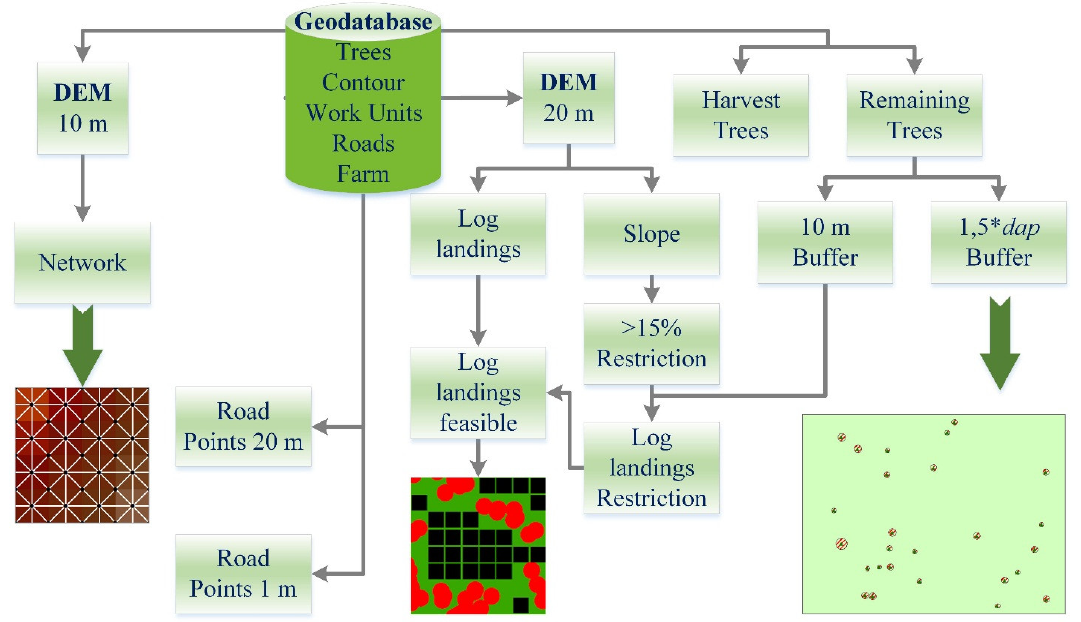
Figure 6. Simplified flowchart of the steps needed to prepare data used in the planning.